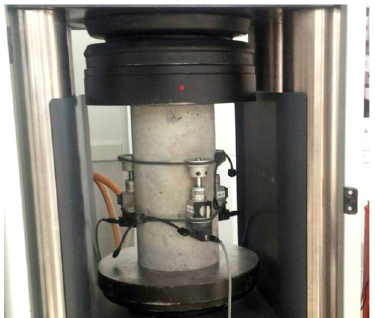
Figure 3. Test setup for testing the static modulus of elasticity of reference concrete (C-REF).